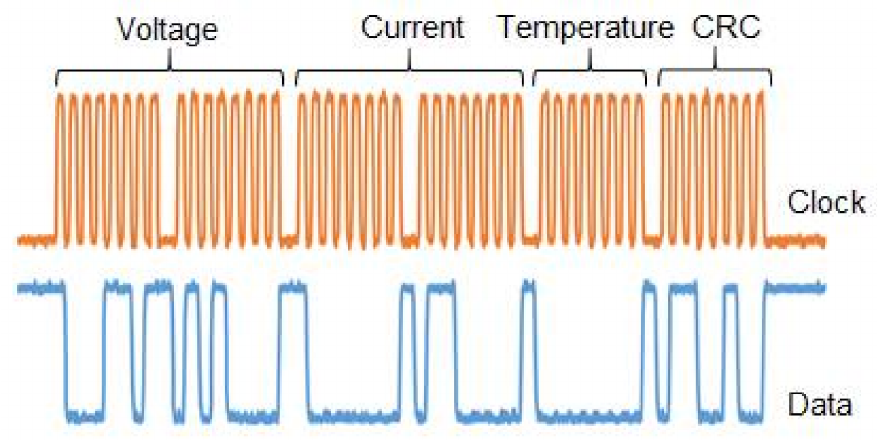
Figure 4. An example of a data frame used in the communication from the sensor unit to the processing unit.